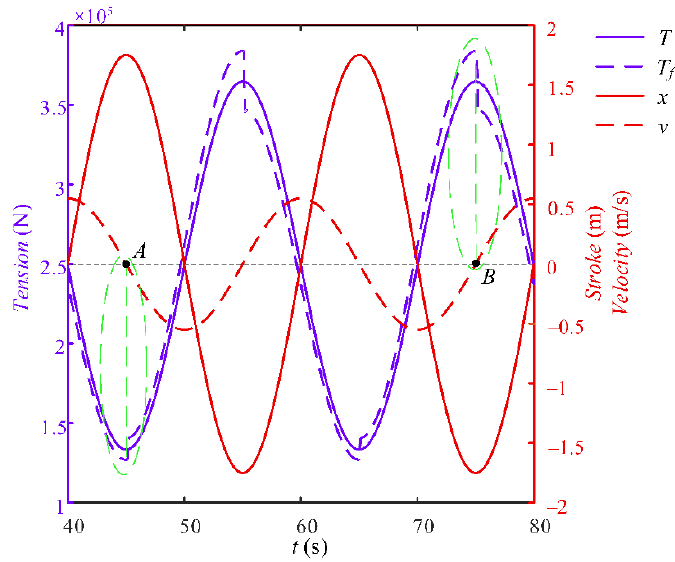
Figure 18. Friction effects on the tension force, T , in time domain.